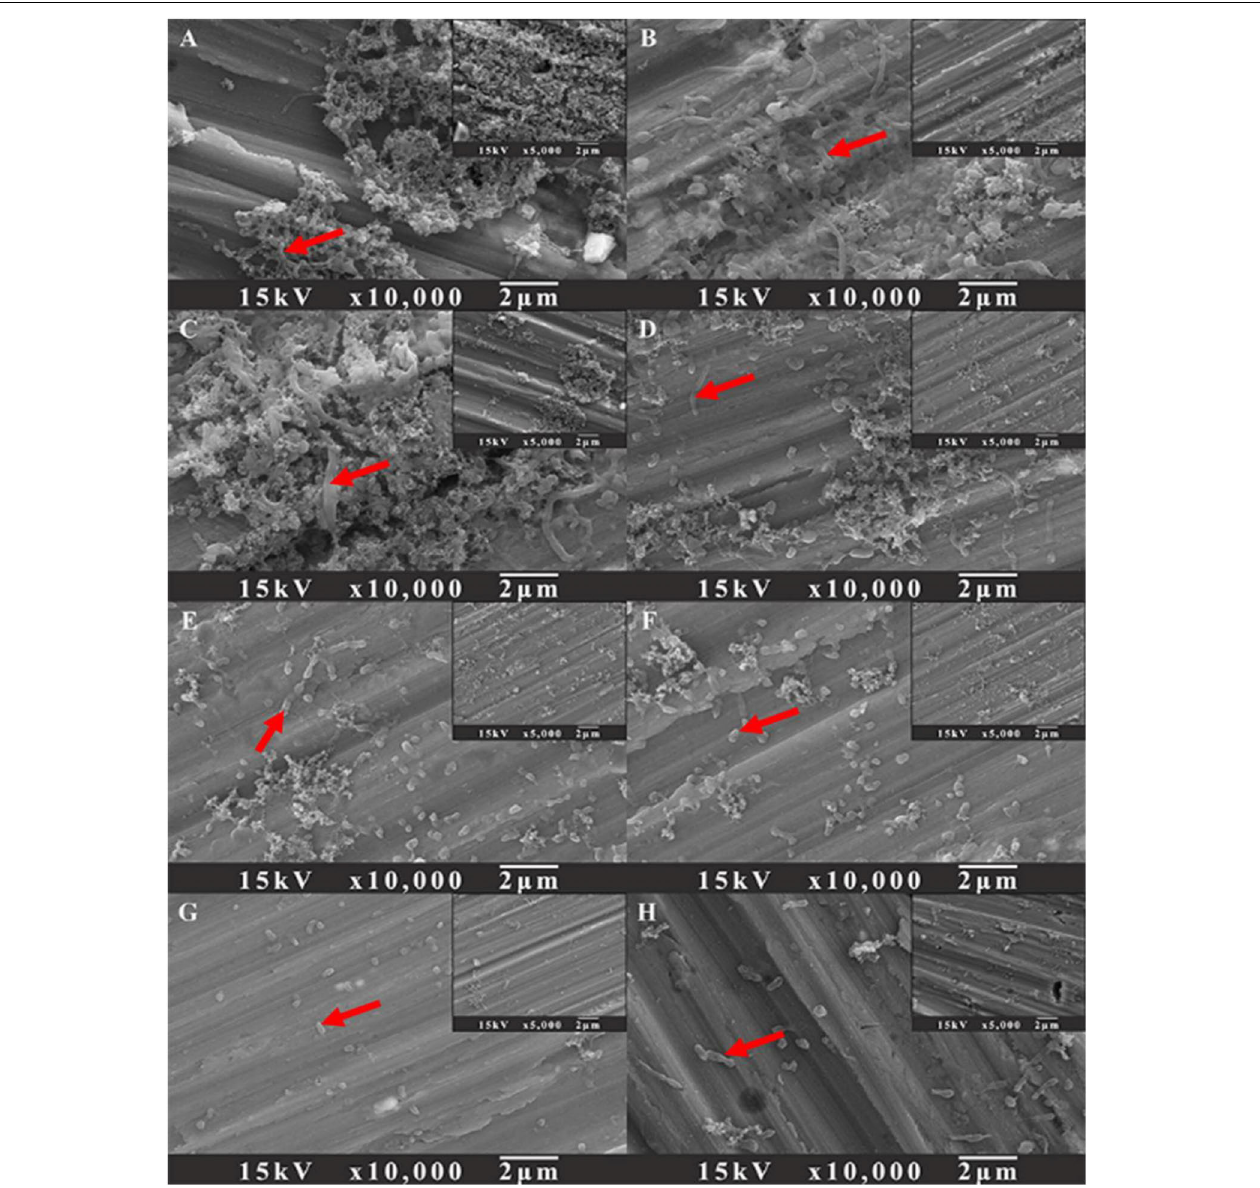
FIGURE 2 | SEM images of sessile cells after 3-day biofilm prevention tests: (A) no treatment (control), (B) 1 ppm D -Tyr, (C) 100 ppm D -Met, (D) 5 ppm CMIT/MIT, (E) 5 ppm CMIT/MIT + 1 ppm D -Tyr, (F) 5 ppm CMIT/MIT + 100 ppm D -Met, (G) 5 ppm CMIT/MIT + 1 ppm D -Tyr + 100 ppm D -Met, and (H) 25 ppm CMIT/MIT. Red arrows indicate the bacterial cells attached on AA2024